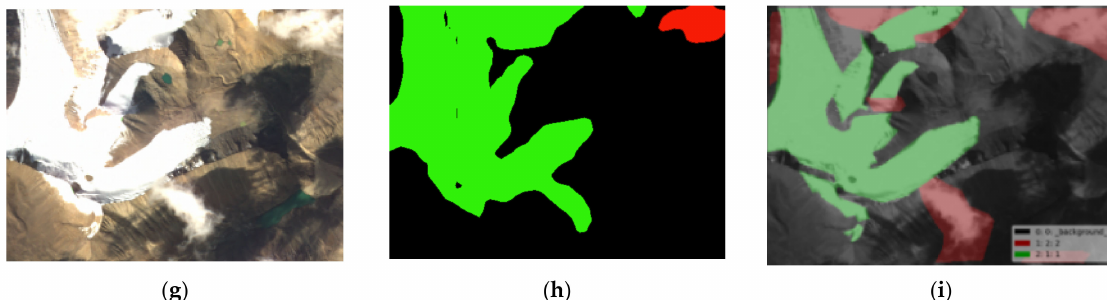
Figure 3. The fine-labeled images and their masks. ( a ) Cloud, ( b ) rough mask, ( c ) fine mask, ( d ) snow, ( e ) rough mask, ( f ) fine mask, ( g ) cloud and snow, ( h ) rough mask, and ( i ) fine mask.